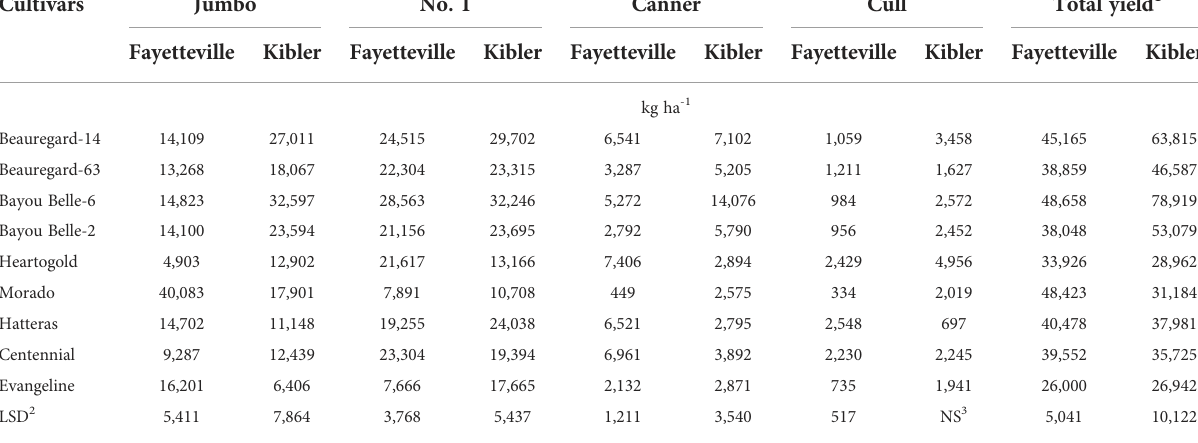
TABLE 8 Yield of sweetpotato cultivars by grade (kg ha -1 ) averaged across weedy and weed-free plots in Fayetteville and Kibler, AR, 2021. Cultivars